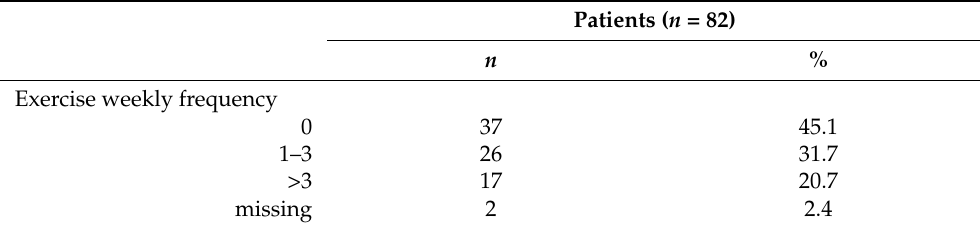
Table 4. Weekly frequencies of patients’ physical